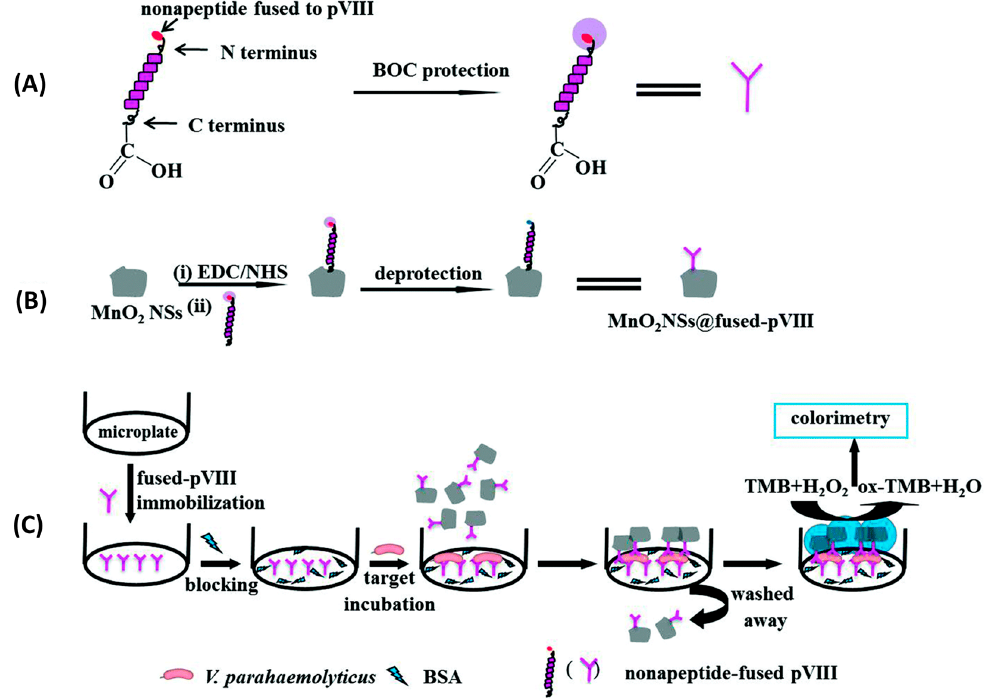
Figure 12. Schematic illustration of colorimetric detection of V. parahaemolyticus . ( A ) V. parahaemolyticus -specific pVIII fusion protected by tert-Butyl carbamate. ( B ) The C-terminal end of pVIII fusion was activated by EDC/NHS, bioconjugated with MnO 2 NSs, and the N-terminal of pVIII fusion was deprotected. ( C ) MnO 2 NS@ pVIII fusion as sandwich immunoassay tags for V. parahaemolyticus detection [85]. Copyright 2018, Royal Society of Chemistry.